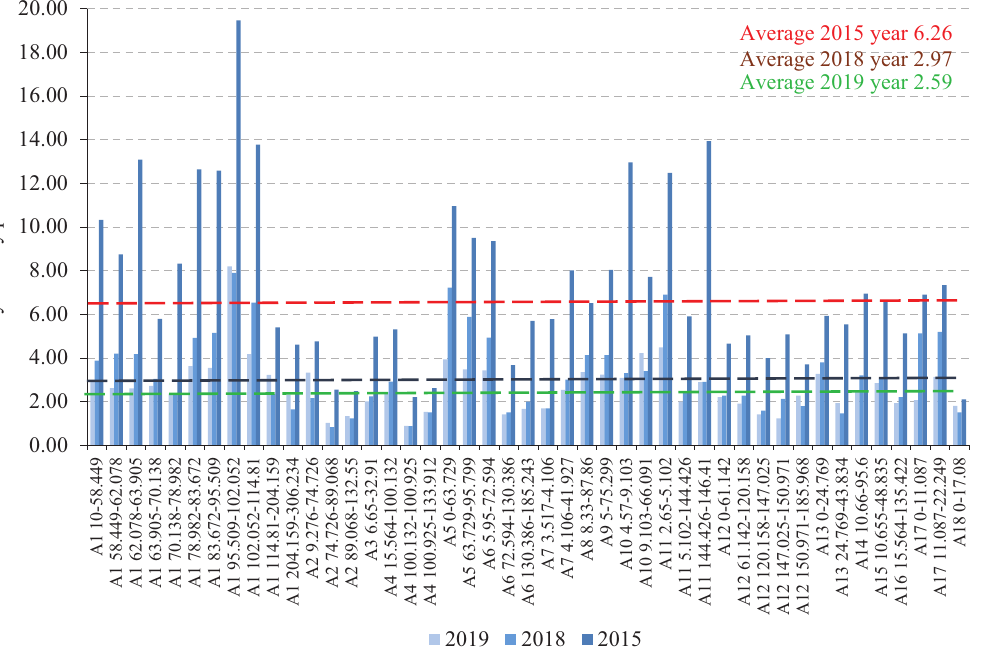
Figure 2. Variations in the expected fatal accident density on main